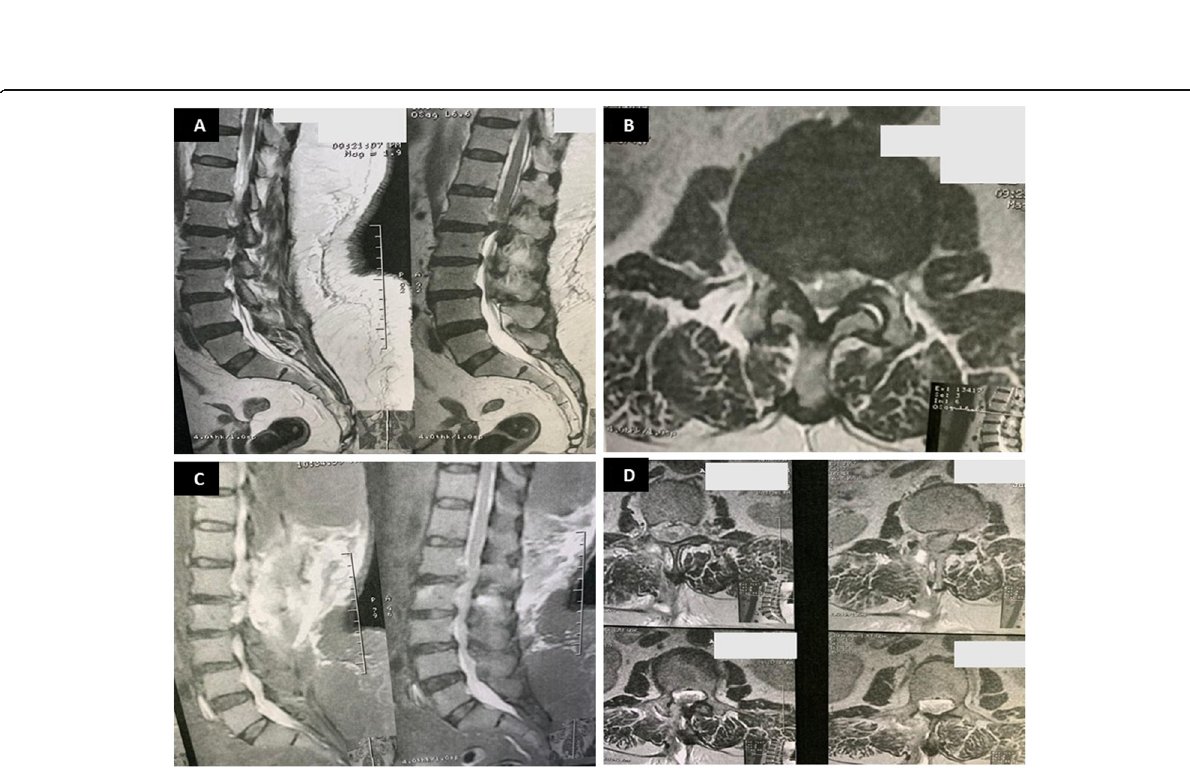
Fig. 3 Preoperative MRI lumbosacral spine of a 67-year-old female presented with right severe femoralgia and motor and visceral deficits for 5 months. a , b Preoperative T2-weighted MR images L1-L2 sizable herniated disc compromising the right root exit foramen. c , d Postoperative sagittal ( c ) and axial cuts ( d ) showing hemi-laminectomy with preservation of the corresponding facet joint and surgical bed with extirpated disc